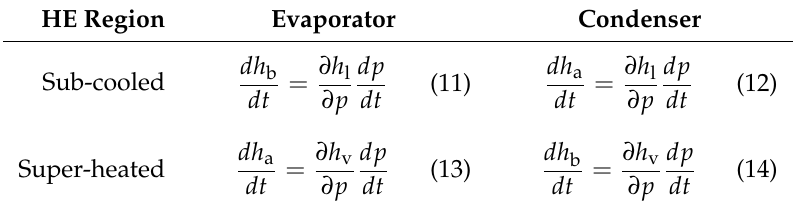
Table 1. Specific boundary enthalpy derivative depending on the heat transfer and control volume. HE, heat